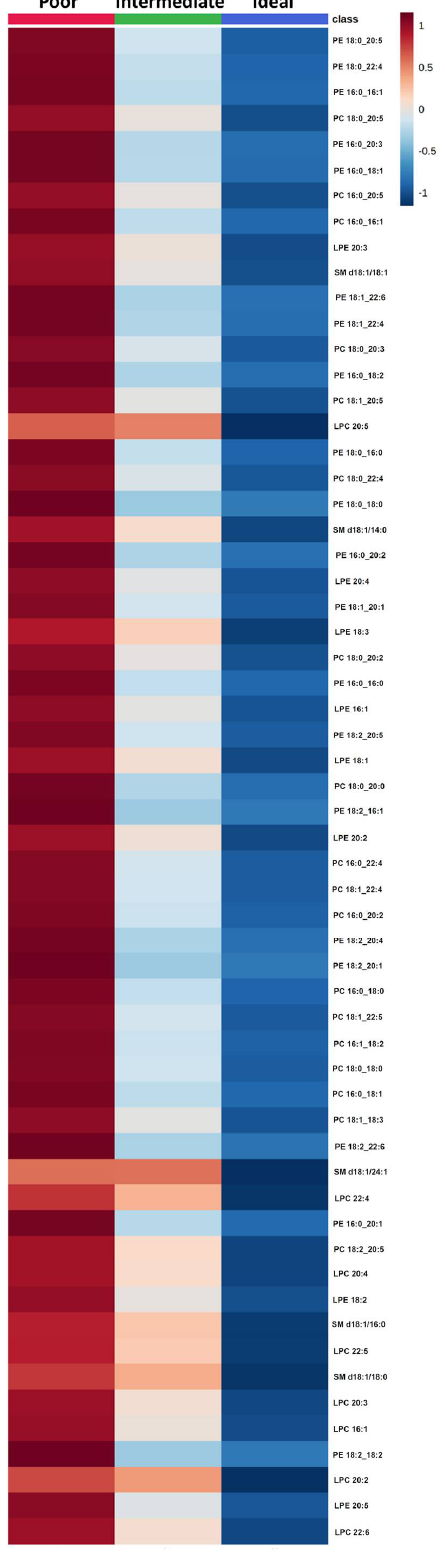
Figure 4. Comparison of lipid species across categories of cardiovascular health. The heatmap shows the average concentrations of important lipid features identified by the ANOVA analysis and grouped by categories of cardiovascular